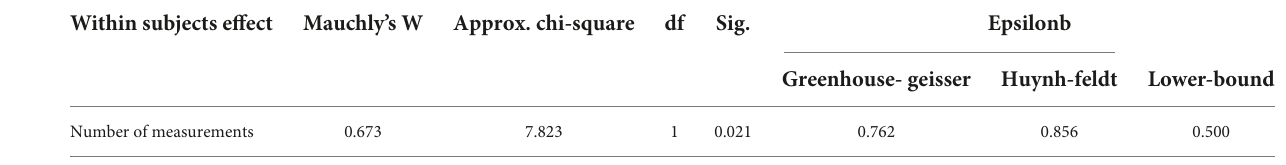
TABLE 6 Mauchly’s test of